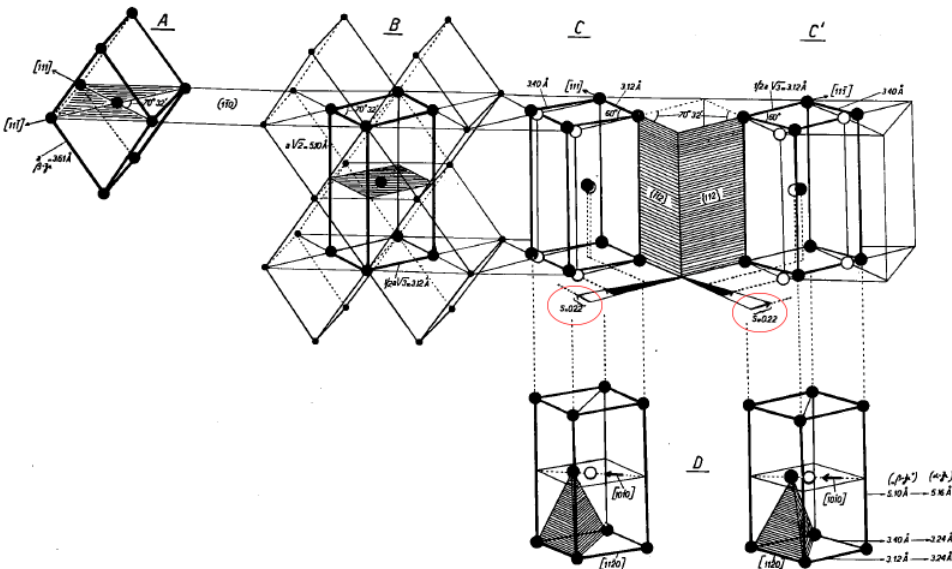
Figure 4. Burgers’ model of bcc-hexagonal close-packed (hcp) transformation. Reprinted from [29] with permission from Elsevier. The two simultaneous shears are marked by the red ellipses.